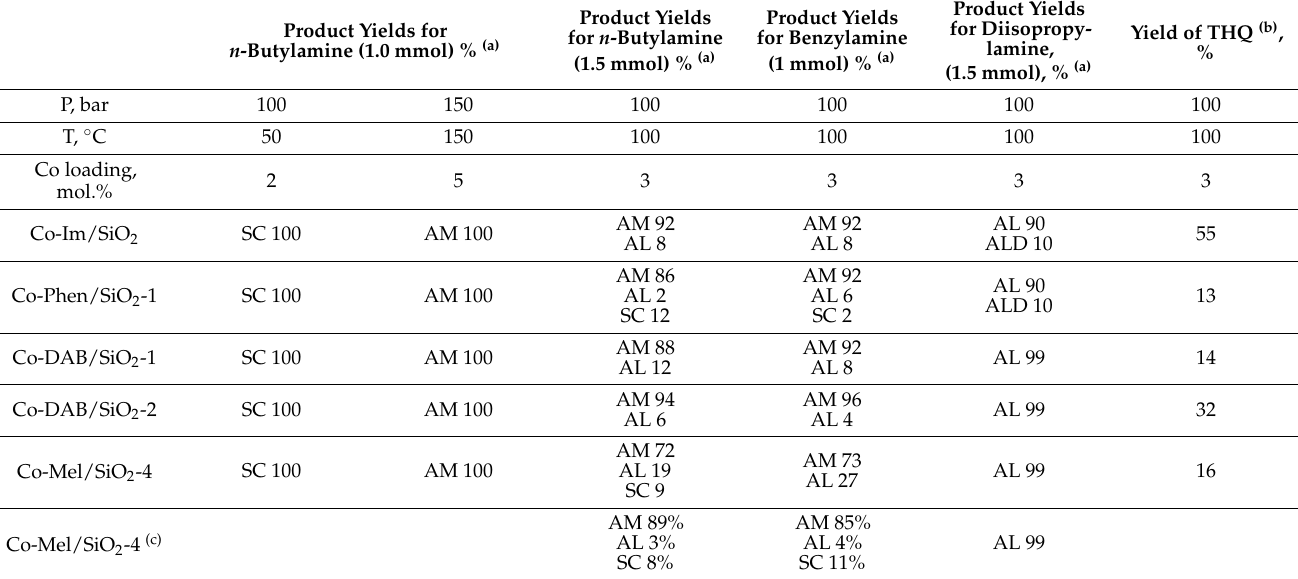
Table 2. The yields of the products in reactions of amination of p -methoxybenzaldehyde to H 2 in presence of Co-containing composites together with the yields of 1,2,3,4-tetrahydroquinoline (THQ) in hydrogenation of quinoline in presence of these